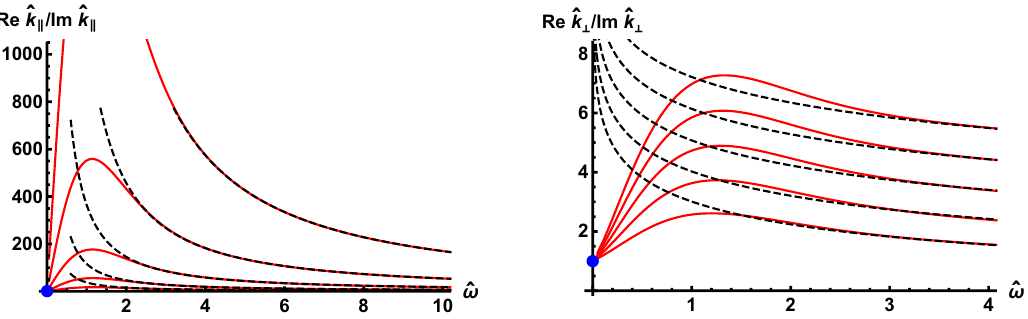
^ d = 1 ; 2 ; 3 ; 4 ; 5 ; 6 10